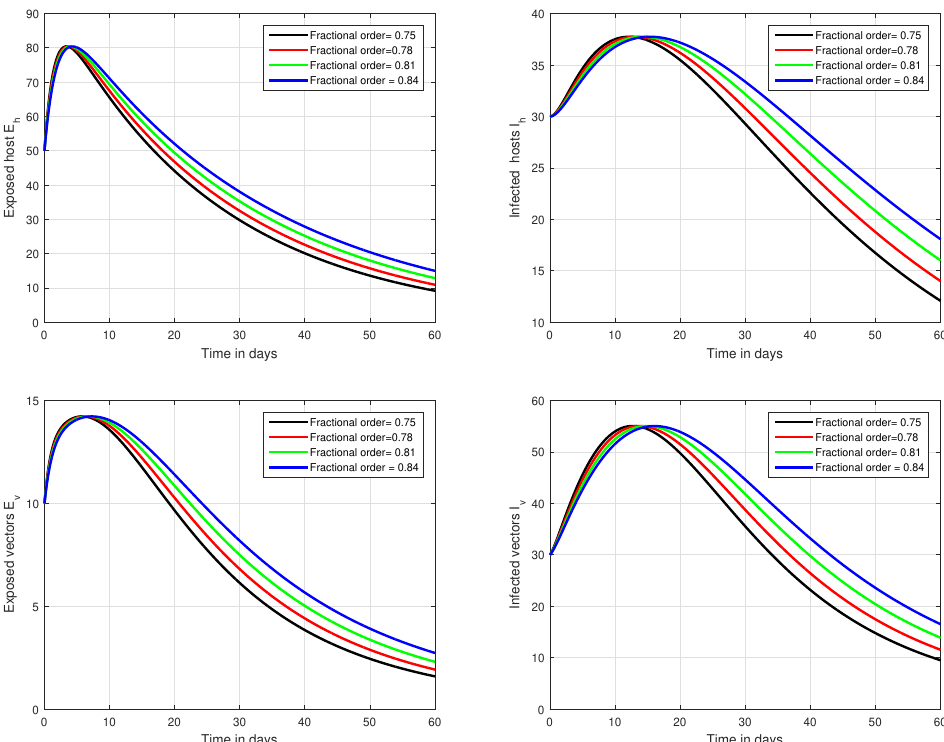
Fractional order= 0.75 Fractional order=0.78 Fractional order= 0.81 Fractional order = 0.84 Figure 2. Graphical view analysis of the solution pathways of exposed and infected classes of our fractional system of Zika virus infection with various fractional values, i.e., ℘ = 0.75,0.78, 0.81,0.84. Fractional order= 0.55 Fractional order=0.60 Fractional order= 0.65 Fractional order = 0.70 0 Time in days Figure 3. Graphical view analysis of the solution pathways of exposed and infected classes of our fractional system of Zika virus infection with various fractional values, i.e., ℘ = 0.55,0.60,